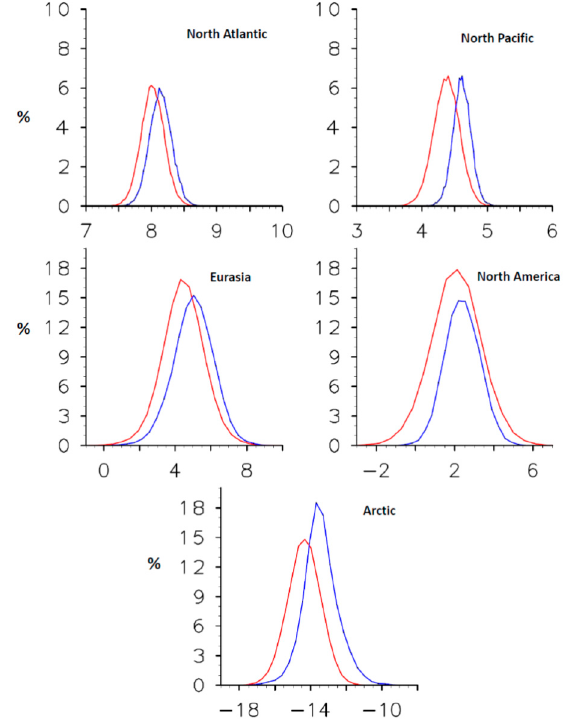
Figure 10. Probability Density Function (PDF) of area averaged SAT in K (along x -axis) for each of the sub-regions in MAM (spring). Red lines for Pos (more sea ice years) and blue line for Neg (less sea ice years).